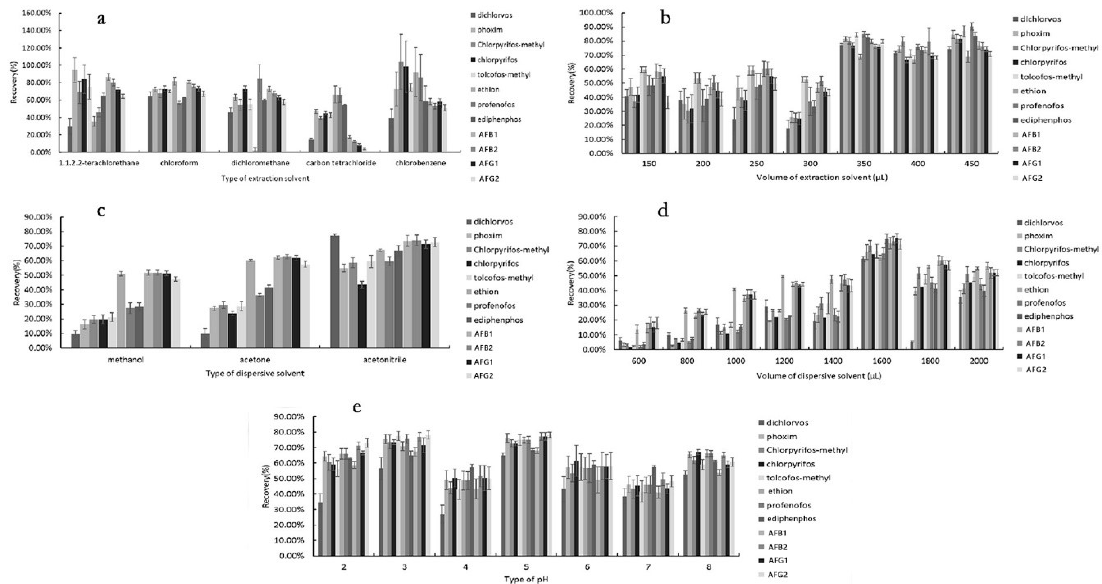
Figure 1. Optimized parameters of the DLLME procedure: ( a ) type of extraction solvent ( b ) volume of extraction solvent (µL) ( c ) type of dispersive solvent ( d ) volume of dispersive solvent (µL) and ( e ) pH. Extraction conditions: volume of chloroform, 350 µL; volume of acetonitrile,1600 µL; sample pH,